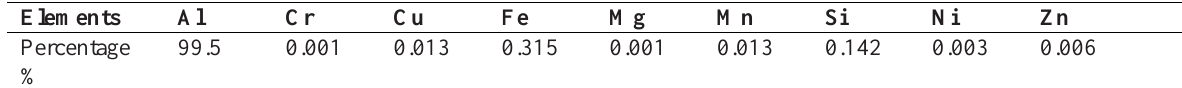
Fig. 4. Surface roughness measurement device Chemical composition of Al 1050 alloy (wt